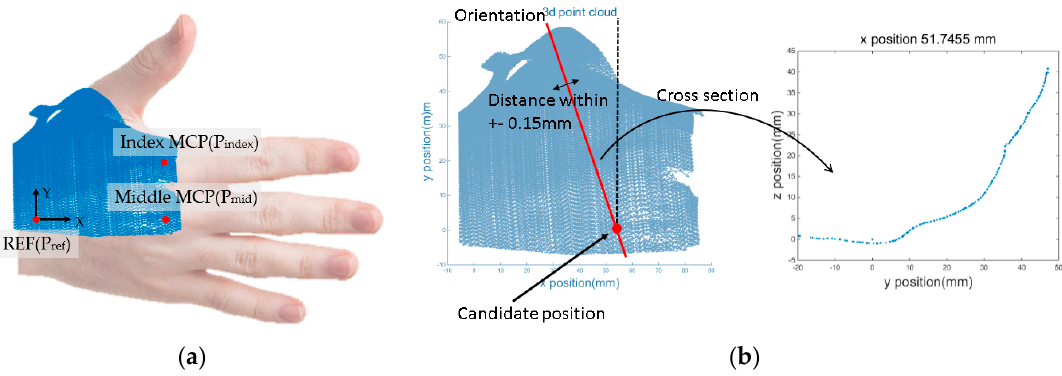
Figure 4. 3D hand surface data conditioning (Subject 3): ( a ) cropping out unused data points; ( b ) align (point pairs picking) process; ( c ) alignment image after fine alignment process.